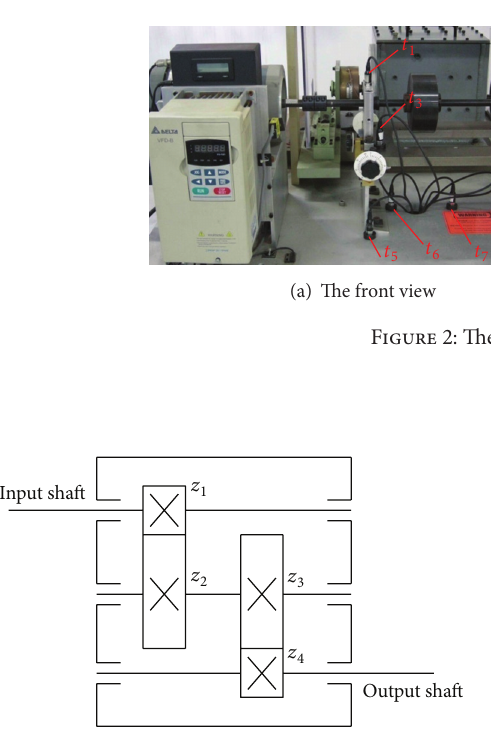
Figure 3: The simplified diagram of gearbox